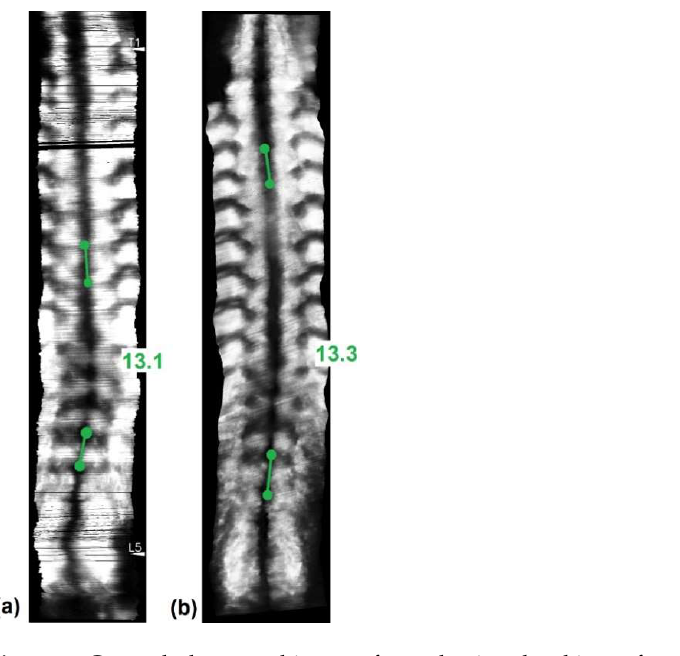
Figure 5. Coronal ultrasound images formed using the skin surface curve VPI method with SPA measurement on ( a ) Scolioscan Air and ( b ) Scolioscan.